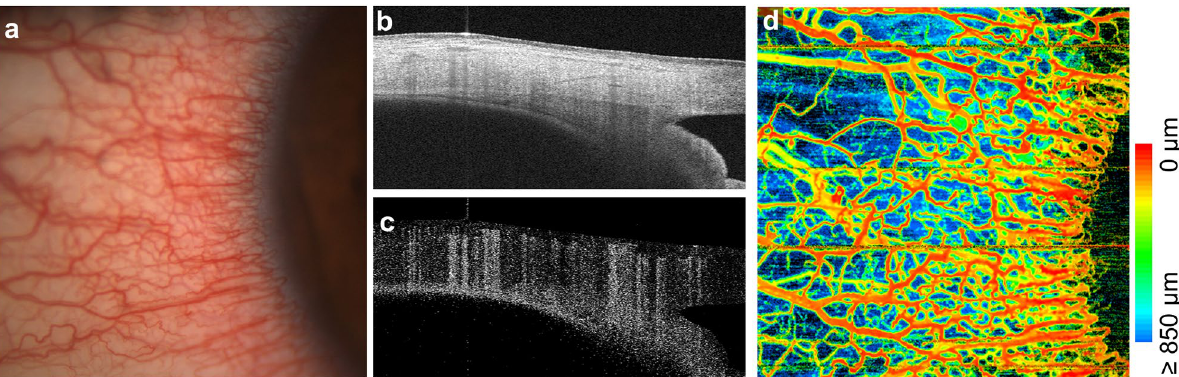
Figure 7. Increased ocular surface vessel density due to contact lens wear. ( a ) Color photography from a slit lamp examination. ( b ) Structural OCT B-scan from the center field of view. ( c ) Corresponding OCTA B-scan. ( d ) Depth resolved OCTA which is color coded by the relative vessel depth beneath the anterior conjunctiva